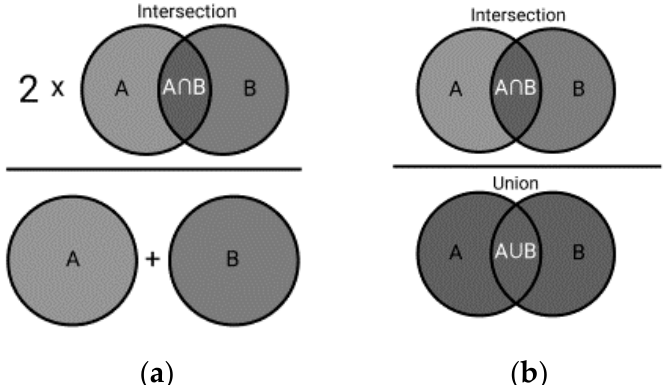
Figure 3. Calculation of segmentation quality metrics: Dice similarity coefficient ( a ) and Intersection over Union ( b